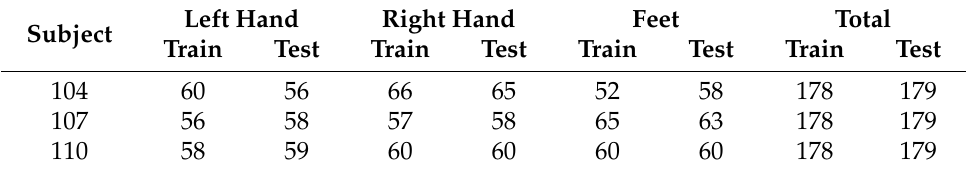
Table 1. Number of examples for the different movements of each